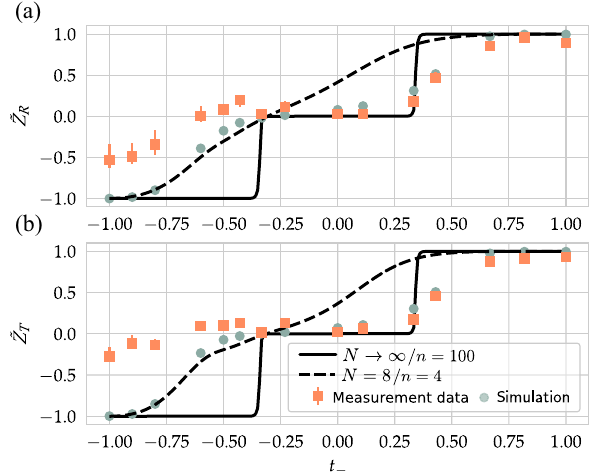
˜ Z ˜ Z FIG. 6. MBTIs R and T in the ESSH model for indicating a symmetry-broken phase in the region near t − ≈ 0 . The notations are the same as in Fig.